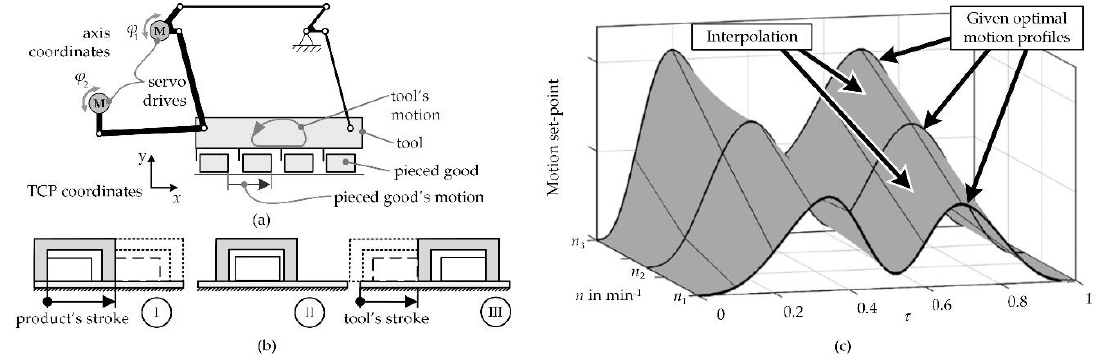
Figure 1. Example process. ( a ) Intermittent transport of pieced goods along a horizontal path with a servo-driven five-bar linkage. ( b ) Principles of a motion approach for the transport of pieced goods. ( c ) Characteristic map of operating speed-dependent motion profiles. Based on [2,4].